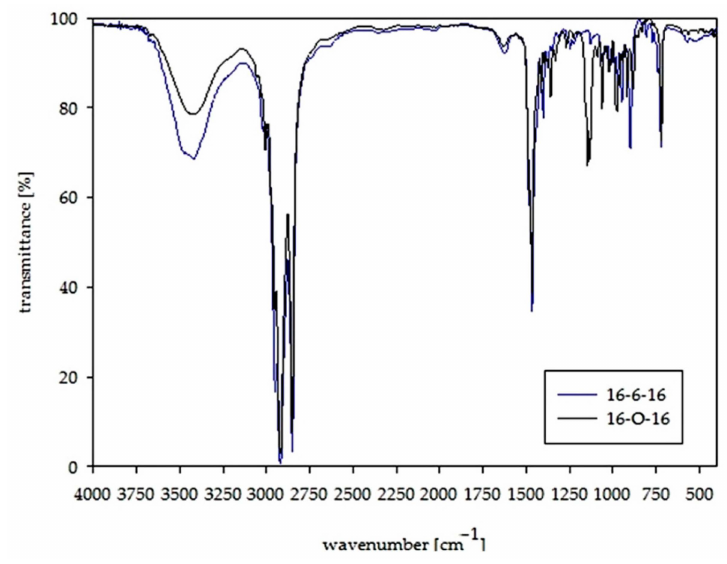
Figure 2. FTIR spectra for 16-6-16 and 16-O-16.